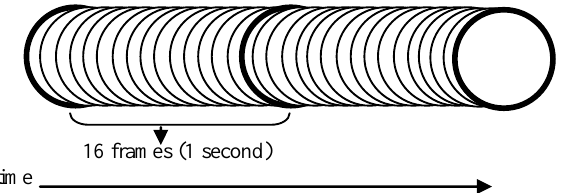
Figure 7. A fragment of immersive video divided into 360° frames.